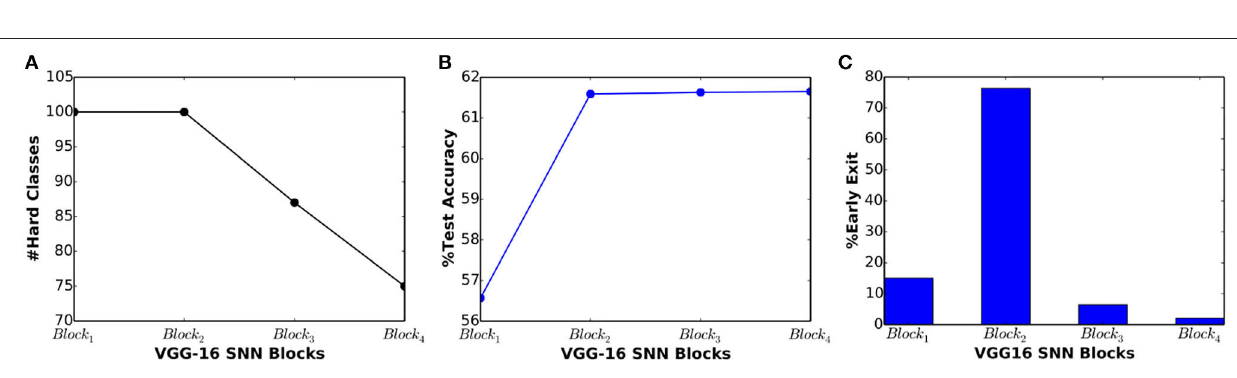
FIGURE 9 | (A) Number of output classes, (B) test accuracy, and (C) percentage of exiting inputs vs. block depth for VGG-16 spiking neural network (SNN), trained on the CIFAR-100